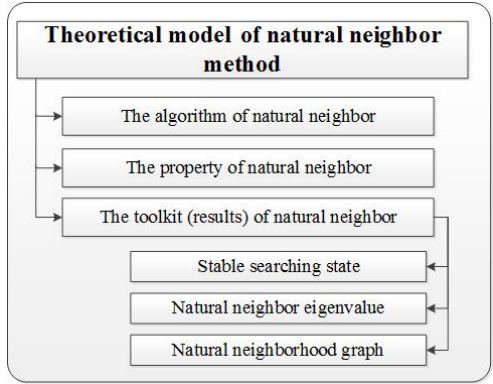
Fig. 1 Basic framework of the NaN